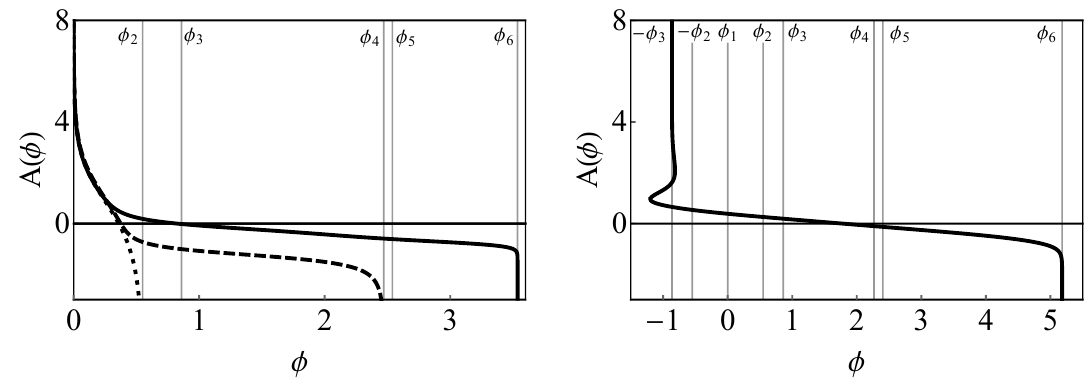
Figure 17 . Left: the solid line is a skipping (cid:13)ow that skips four extrema. The dashed line is a (cid:13)ow that skips two extrema. Together with the (cid:13)ow ending at (cid:30) 2 , the dotted line, there are three di(cid:11)erent vacua for the CFT 1 . Right: an exotic RG (cid:13)ow that bounces twice and skips several